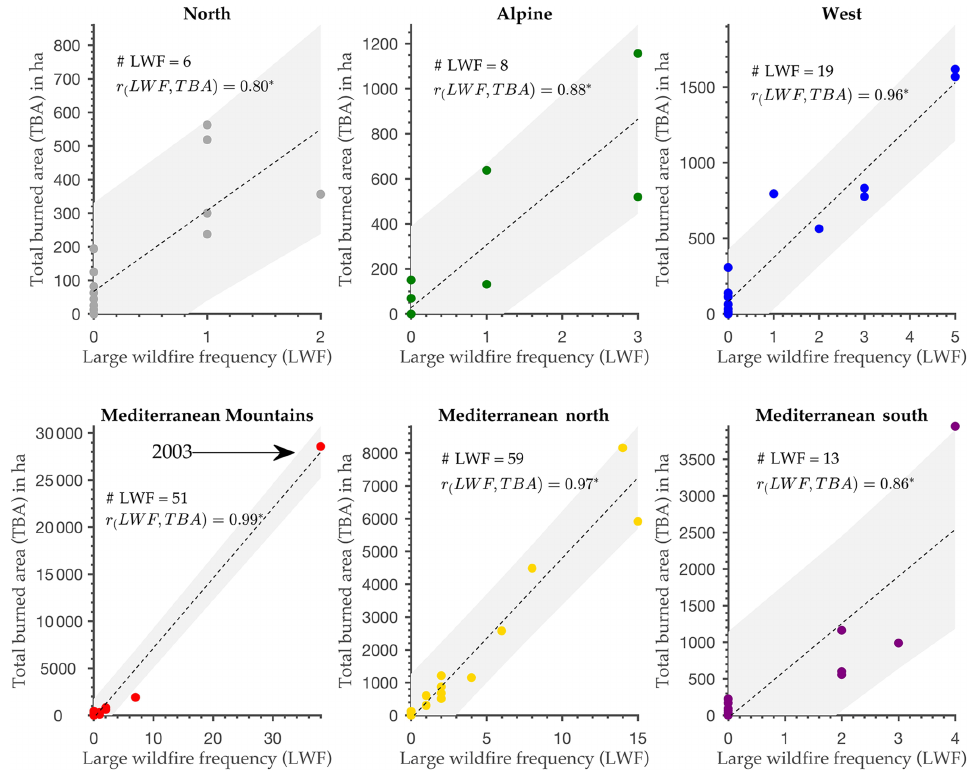
Figure 2. Interannual relationships between the annual frequency of large wildfires ( > 100ha) and the total annual burned area. The total number of large wildfires as well as Pearson correlations are indicated for each region. The symbol ∗ indicates significant correlations at the 95% confidence level. The linear fitting and the 95% confidence intervals are also shown. Table 3. Equations describing daily large-wildfire ( > 100ha) probabilities at 8km for each environmental region. The second column indi- cates the number of large wildfires observed from 2001 to 2016. The third column gives the β (cid:48) x parameters and the last column indicates the model selection frequencies, i.e., the percent of bootstraps for which there was